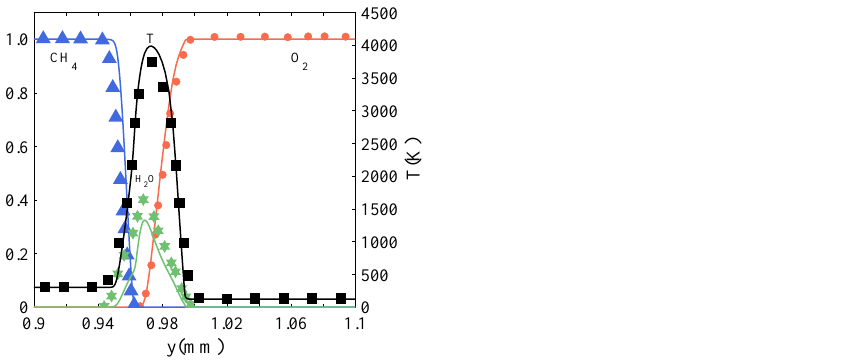
Figure 4. Validations of laminar counterflow diffusion flames at 100 bar (the solid lines indicate the present work and the symbols represent the data from Wang et al.